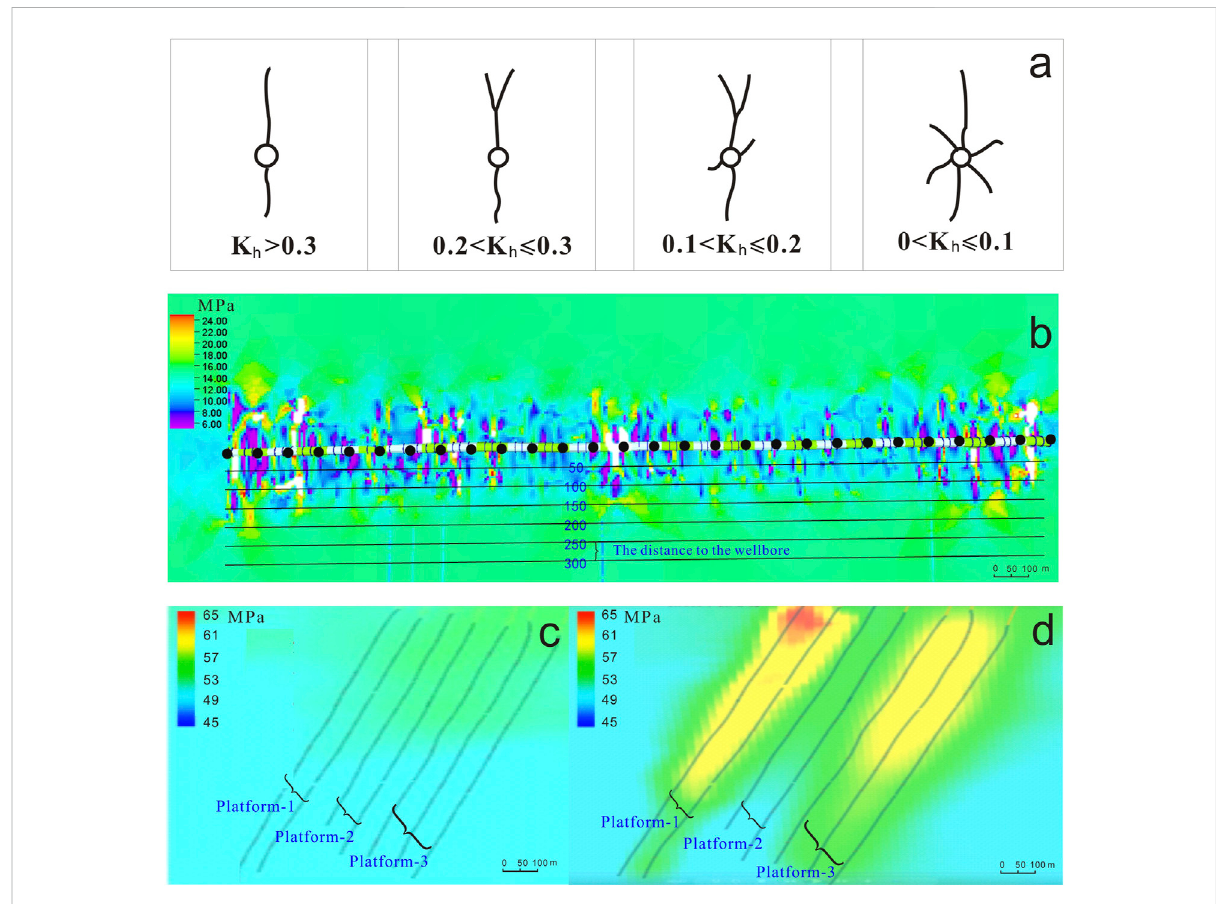
FIGURE 5 (A) The relationship between the stress difference coef fi cient and the complex fracture network; (B) numerical simulation result in the difference of horizontal stress; (C) minimum principal stress before hydraulic fracturing; (D) minimum principal stress after hydraulic